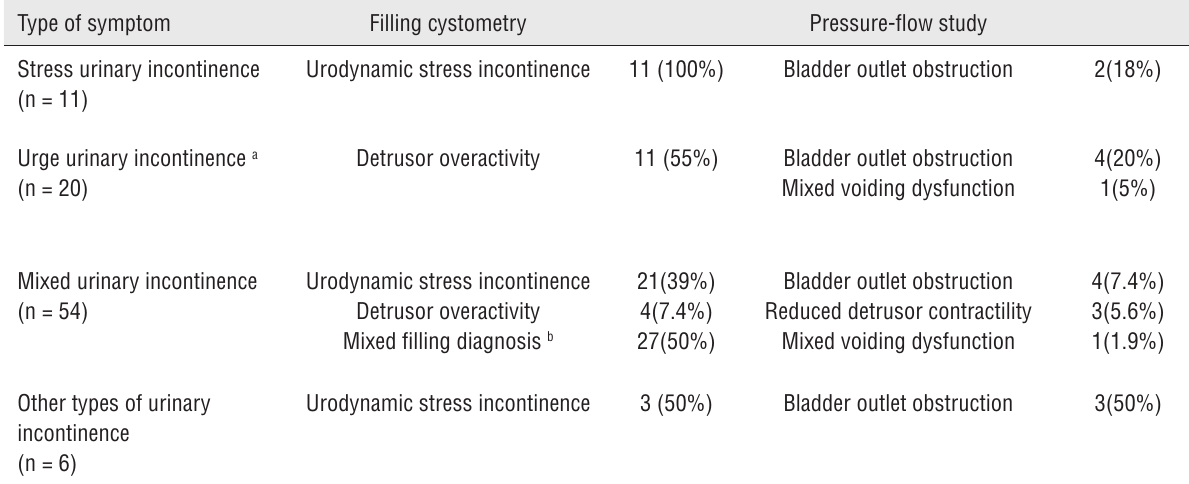
Table 2 - Urodynamics results in women with previous anti-incontinence surgery according to the type of urinary incontinence symptoms (n = 91).